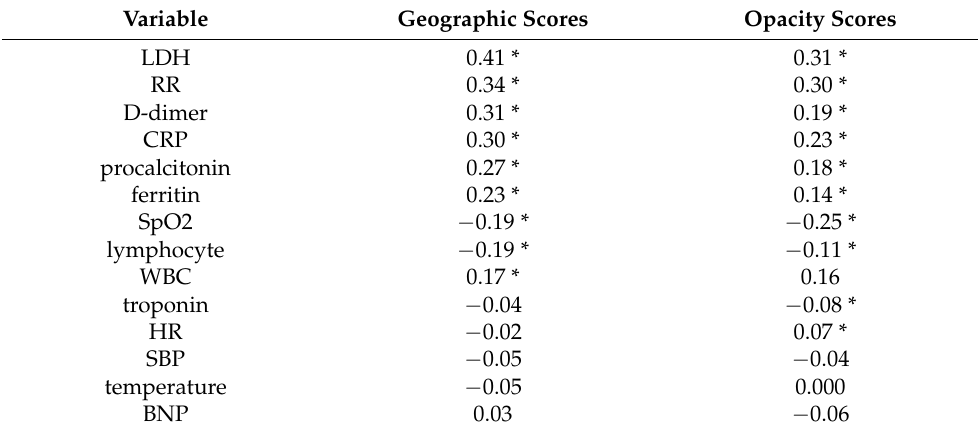
Table 3. Correlation (R) of geographic and opacity CXR scores with clinical variables. * p < 0.05. Data from admission and outcome were analyzed together.